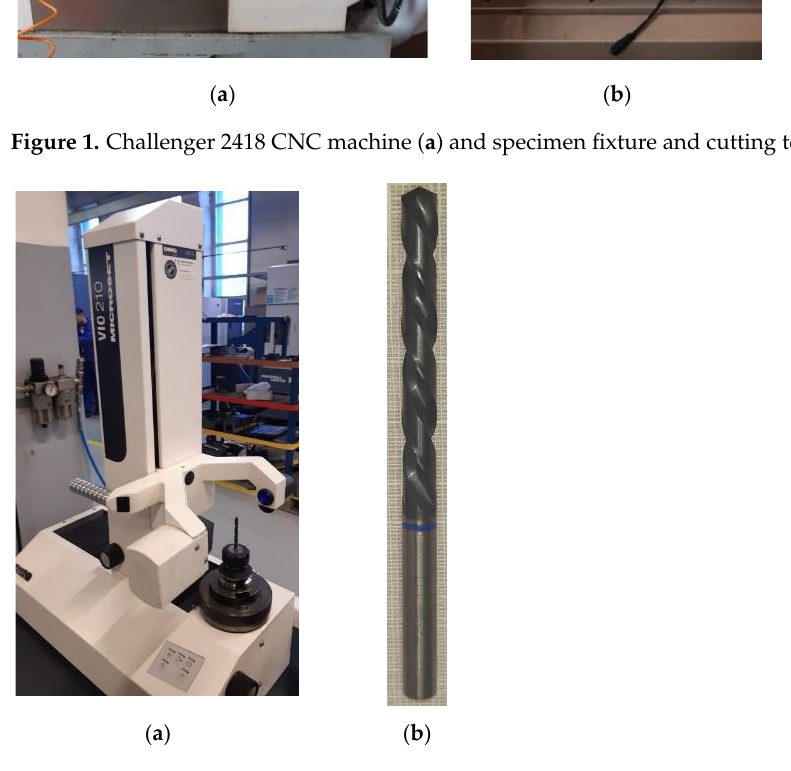
Figure 2. VIO 210 MICROSET cutting tool measuring machine manufactured by DMG ( a ) and the twist drill ( b ).